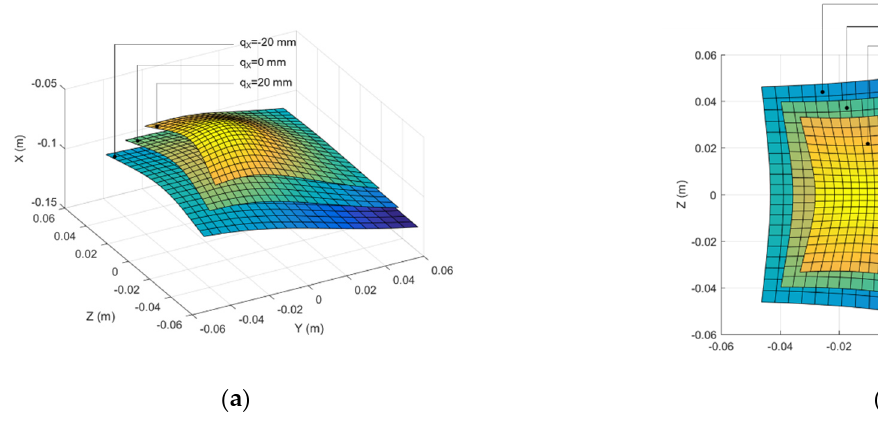
Figure 6. Workspace: ( a ) oblique view; ( b ) top view.